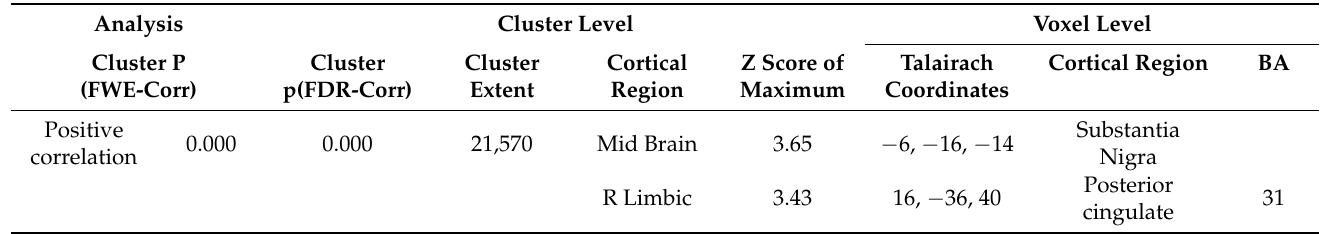
Table 1. Regression analysis showing the CSF DAT levels-related areas of increased 18F-FDG brain uptake.